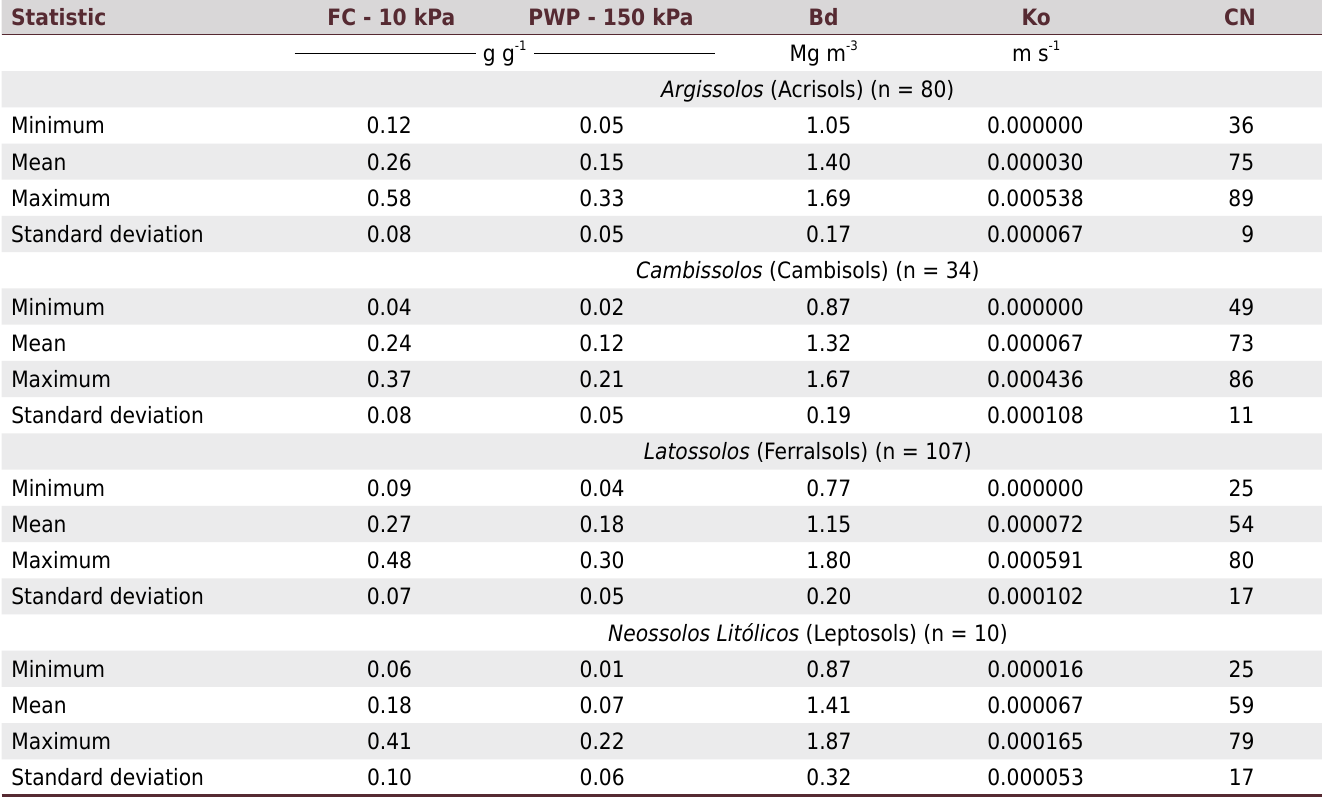
Table 2. Statistical distribution of the soil properties used as parameters of water balance in the BALSEQ model Statistic FC - 10